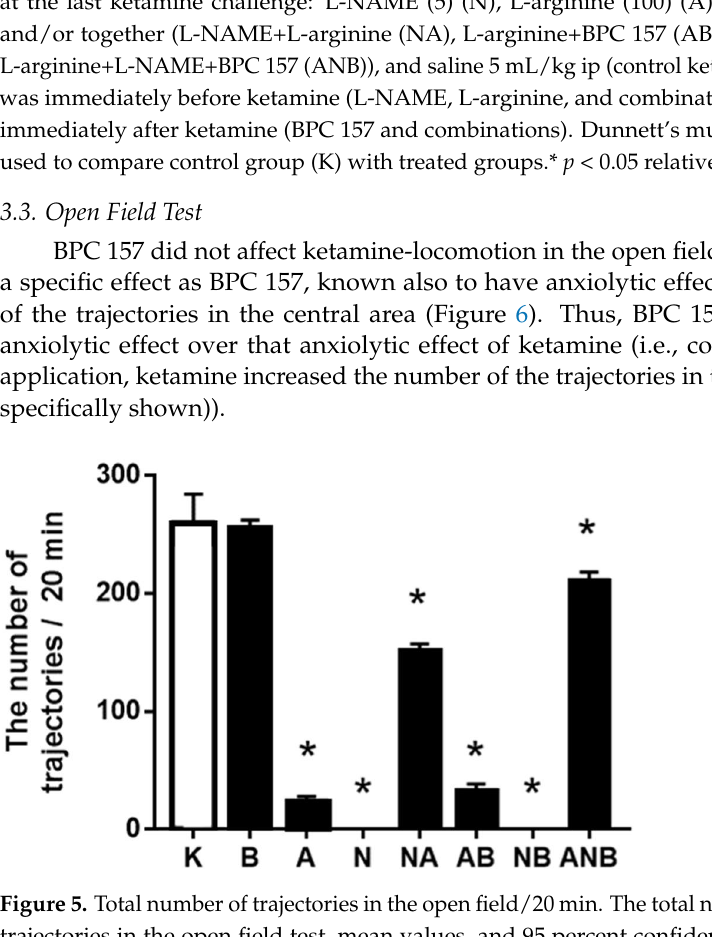
Figure 6. Proportion of trajectories in the center of the open field (%). The proportion of ketamine— induced trajectories in the open field test (OFT), mean values, and 95 percent confidence intervals are shown. In the ketamine rats (30 mg/kg ip), medication (mg/kg ip) was: L-NAME (5) (N), L-argi- nine (100) (A), BPC 157 (0.01) (B), alone and/or together (L-NAME+L-arginine (NA), L-arginine+BPC 157 (AB), L-NAME+BPC 157 (NB), L-arginine+L-NAME+BPC 157 (ANB)), and saline 5 mL/kg ip (control ketamine) (K). The application was immediately before ketamine (L-NAME, L-arginine, and combination) or the application was immediately after ketamine (BPC 157 and combinations). Dunnett’s multiple comparison test was used to compare control group (K) with treated groups. * p < 0.001 relative to ketamine.